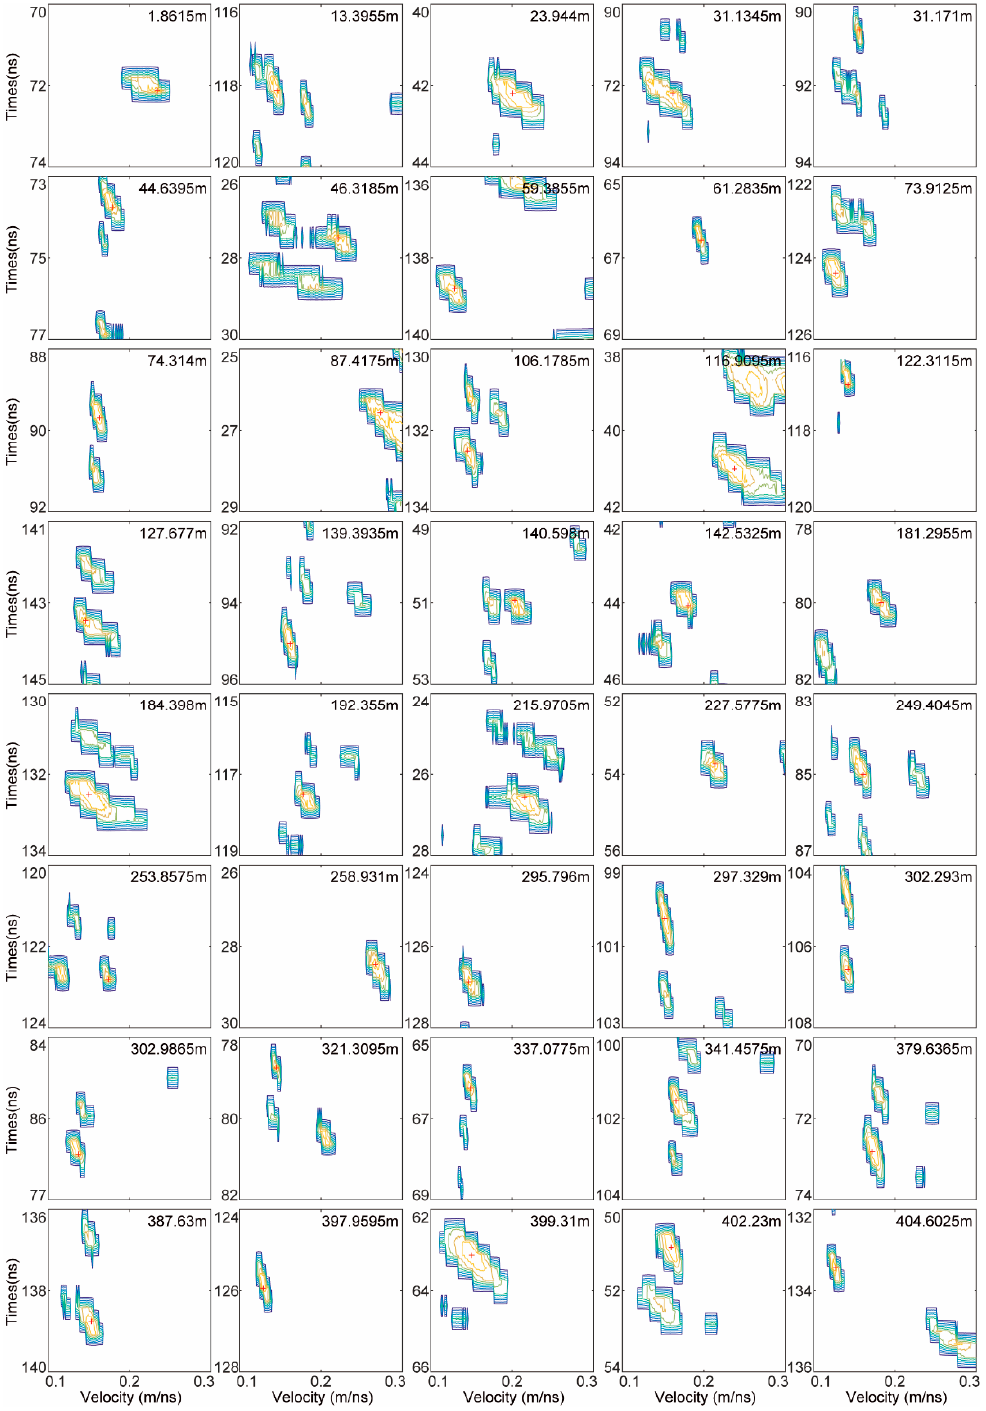
Figure 7. Semblance analysis contour of diffraction hyperbolas after screening the LPR CH-2B data, where the normalized stacked amplitude threshold of 0.6 was used. The red-cross indicates the maximum value of 1 for the semblance analysis. Table 2. The estimated results of velocity and depth for the LPR data.